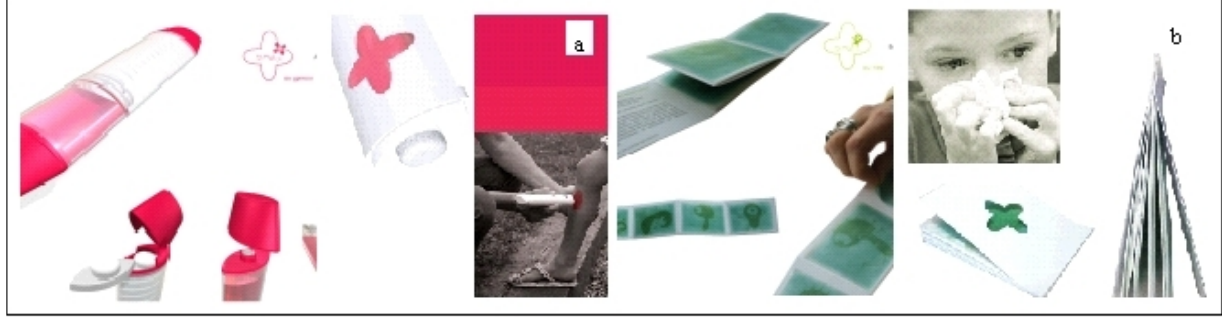
Figure 11. Antiseptic as a magic wand (a) and Balm with essential oil